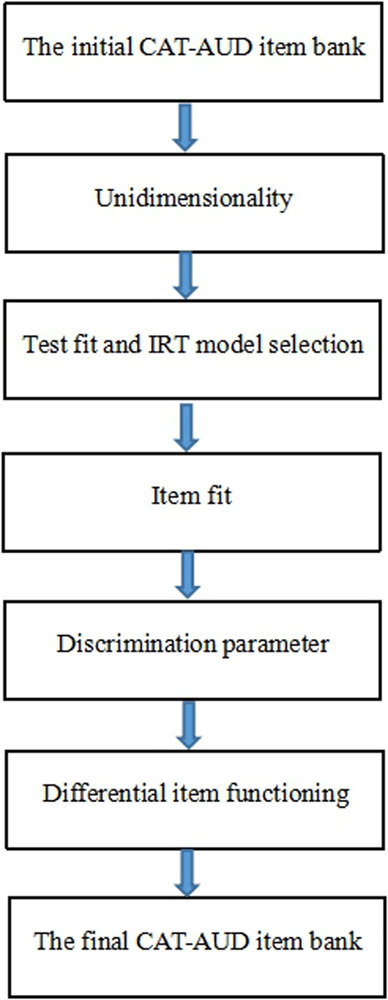
The steps of the psychometric measurement requirements of IRT used for the item bank generation.